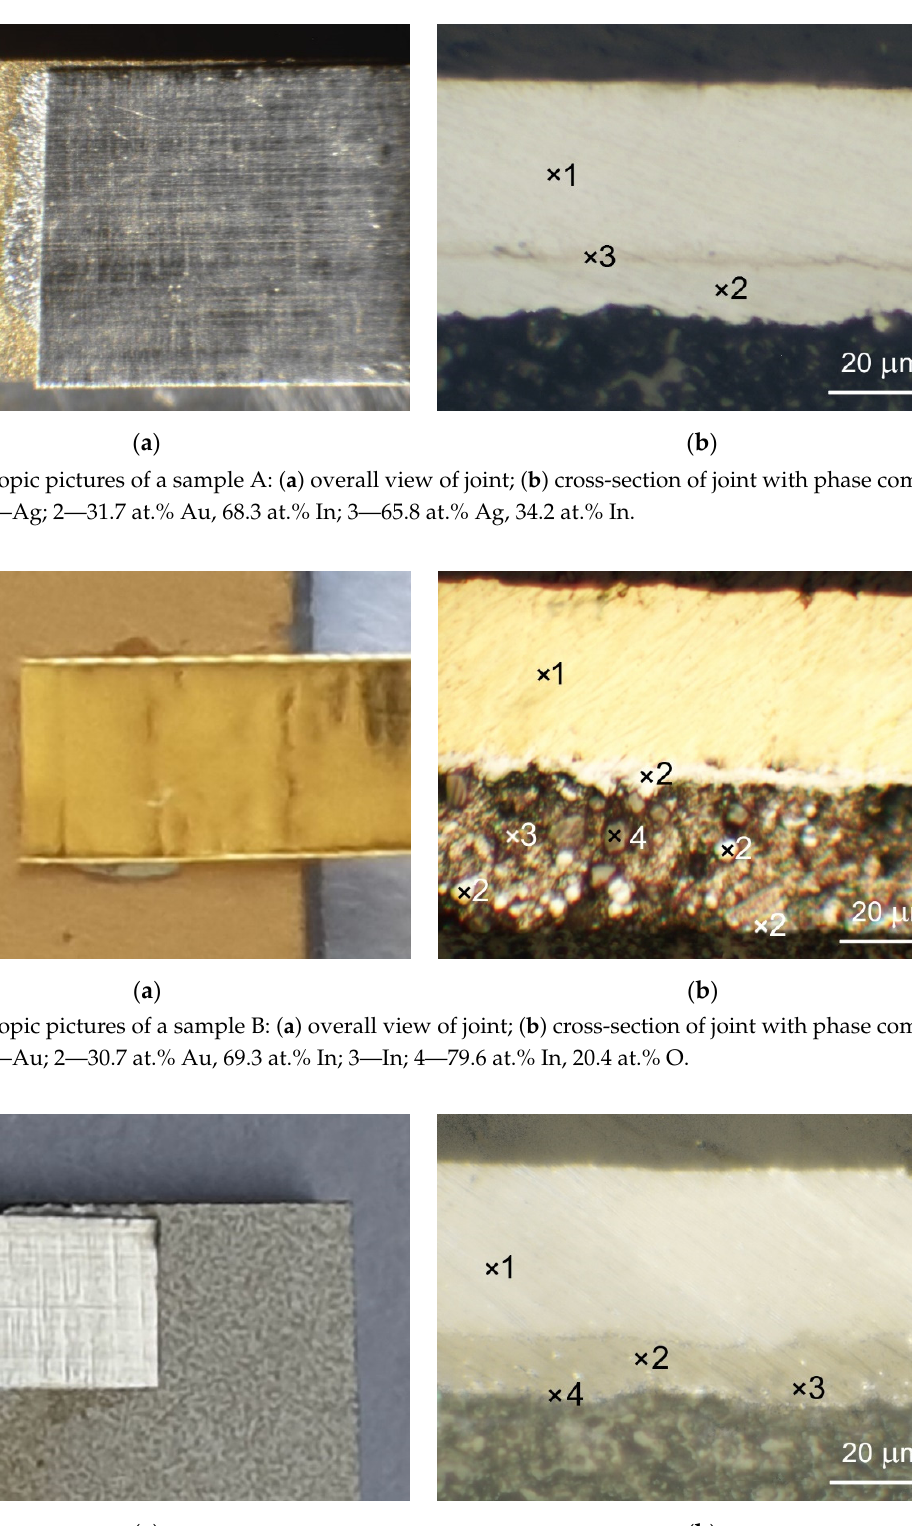
Figure 8. Microscopic pictures of a sample B: ( a ) overall view of joint; ( b ) cross-section of joint with phase composition of different areas: 1—Au; 2—30.7 at.% Au, 69.3 at.% In; 3—In; 4—79.6 at.% In, 20.4 at.% O.